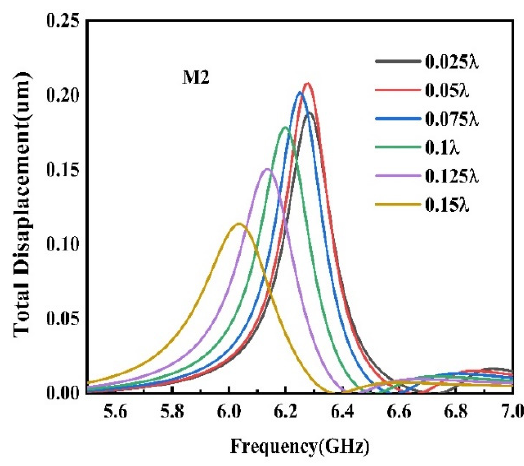
best, but the corresponding K 2 value in Figure 10 is small at this time. When K 2 / λ = 0.075, the corresponding resonant wave peak is relatively high, and the corresponding v p and K 2 are relatively high, respectively, at 12,520 m/s and 5.83%.